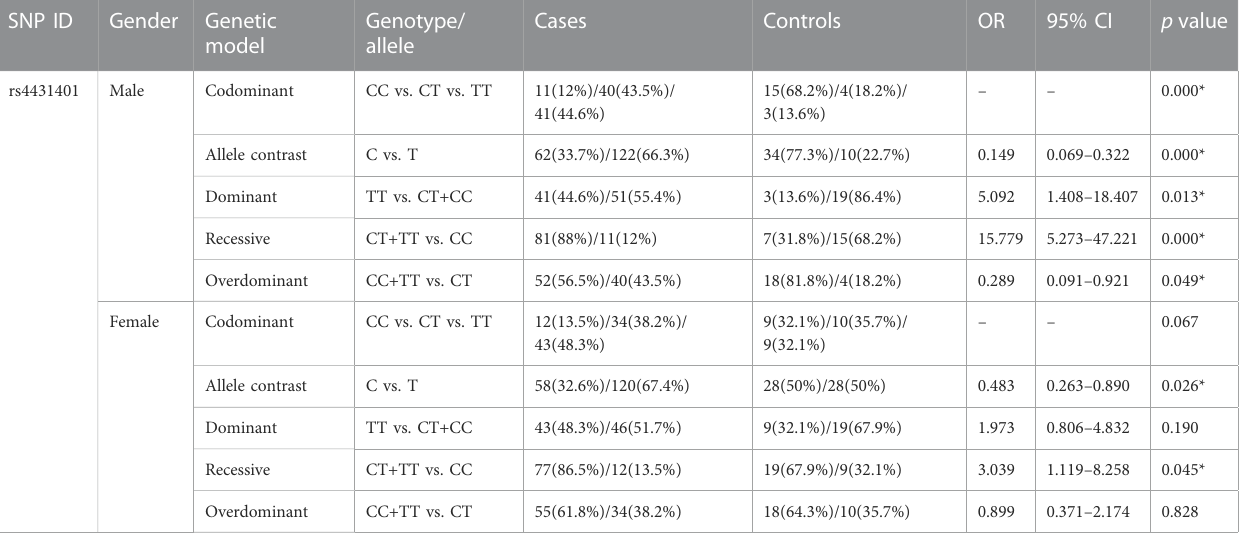
TABLE 3 Genotypic and allelic distribution of the CD73 gene between all patients and controls in different genders. SNP